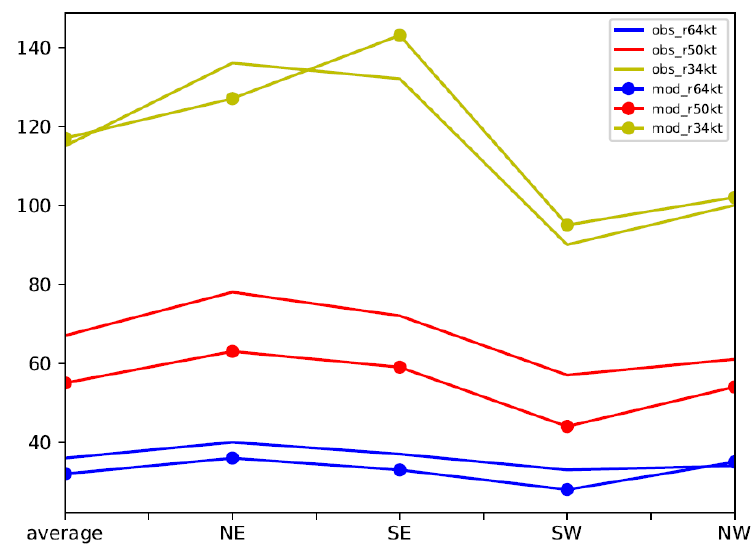
Figure 6. The radii (nautical miles) of winds at 64 kt, 50 kt and 34 kt in the 4 quadrants of NE, SE, SW and NW and the direction-average for hurricane Dorian 2019.